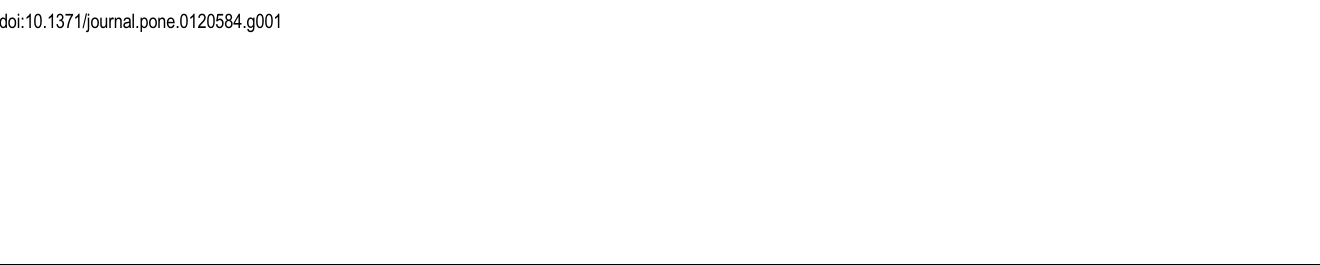
PLOS ONE | DOI:10.1371/journal.pone.0120584 March 23,